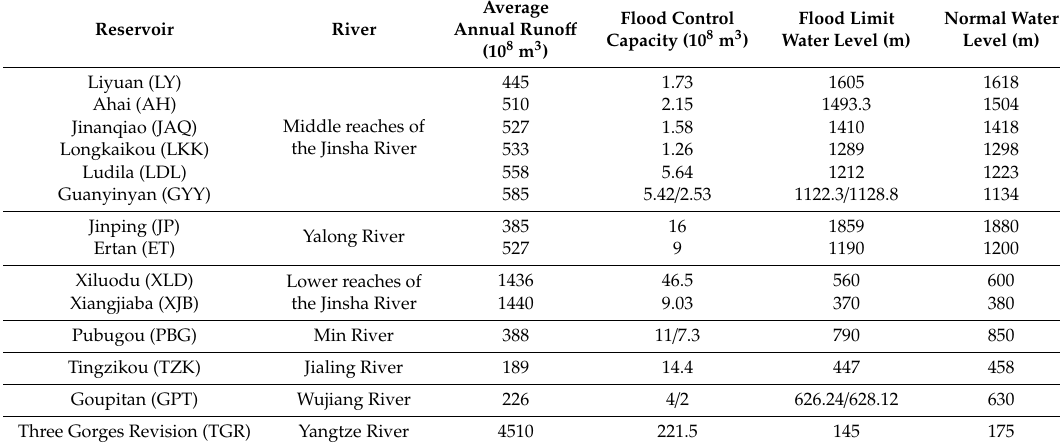
Table 1. The selected rivers and